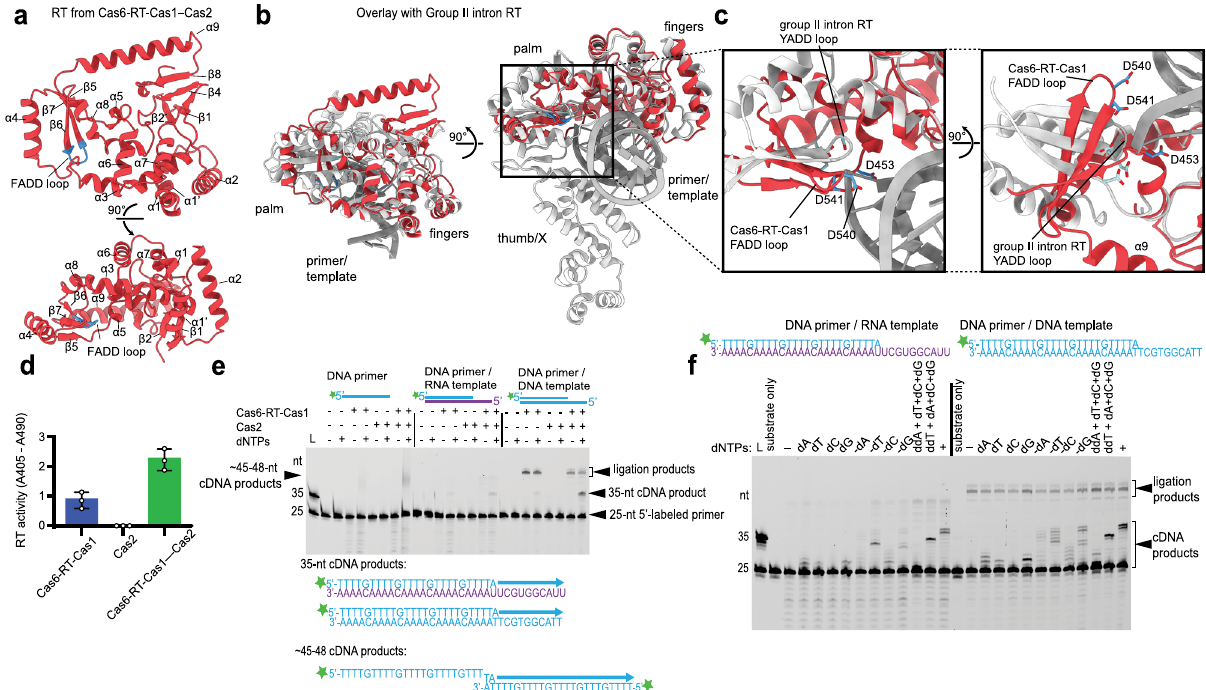
Fig. 5 Cas6-RT-Cas1 catalyzes cDNA synthesis with both RNA and DNA templates. a Architecture of RT domain from Cas6-RT-Cas1 — Cas2 (red) and 90° rotation, with FADD motif (blue) indicated. b Alignment and overlay of RT domain from Cas6-RT-Cas1 — Cas2 (red) with group II intron RT (white) bound to primer/template substrate (PDB: 6AR1) and 90° rotation, FADD motif from Cas6-RT-Cas1 — Cas2 colored blue and YADD motif from group II intron RT colored light blue. Palm, fi ngers, and thumb/X regions and primer/template are indicated. c Closeup of RT active site residues of Cas6-RT-Cas1 — Cas2 (blue) and group II intron RT (light blue), shown in stick con fi guration. Two views are shown related by a 90° rotation. d RT activity assays comparing Cas6-RT-Cas1 alone and Cas6-RT-Cas1 — Cas2. RT activity is measured using an ELISA-based colorimetric reverse transcriptase activity assay (error bars, mean ± sd, n = 3 biologically independent experiments) (Catalog No. 11468120910, Roche Diagnostics, Indianapolis, IN). Source data are provided as a Source Data fi le. e Template-driven cDNA synthesis reactions off a fl uorescent DNA primer annealed to DNA and RNA templates. Substrates are schematized (DNA, blue; RNA, purple). Expected cDNA synthesis reactions are indicated. Star indicates 6-carboxy fl uorescein label. Results are representative of three independent experiments. f Template-driven cDNA synthesis reactions in the absence of different dNTPs and in the presence